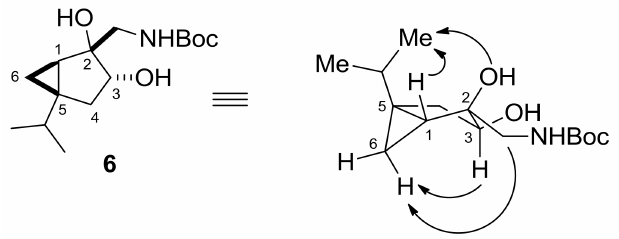
Figure 1. Determination of the relative configuration of 6 by